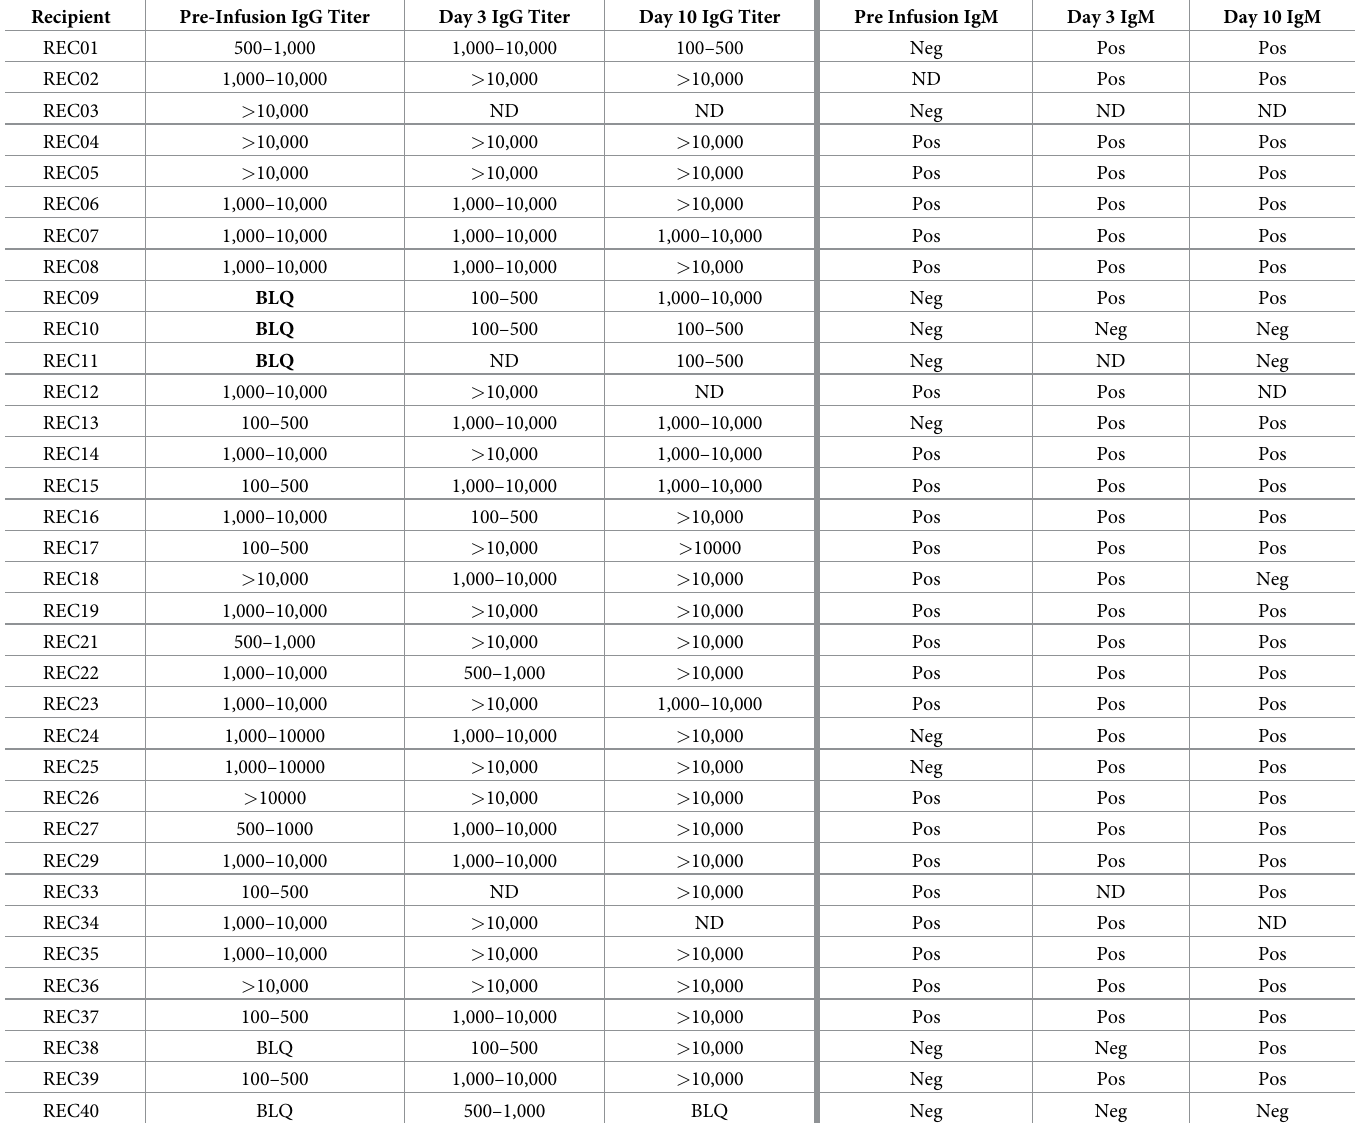
Table 8. IgG and IgM SARS-CoV-2 Neutralizing Antibody Titer in Recipient